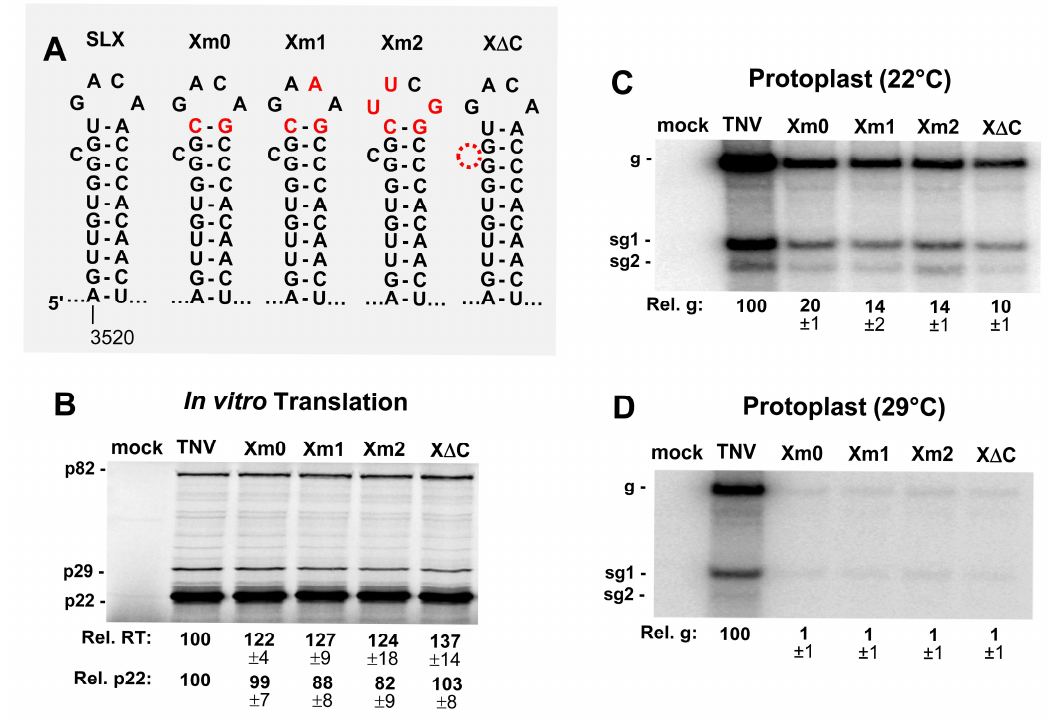
Figure 4. Mutational analysis of the loop and bulge of SLX. ( A ) Wild-type and mutant SLXs, with substituted nucleotides in red. ( B ) In vitro translation analysis of the SLX mutants. ( C and D ) Northern blot analysis of the protoplast infections with SLX mutants at ( C ) 22 ◦ C and ( D ) 29 ◦ C.